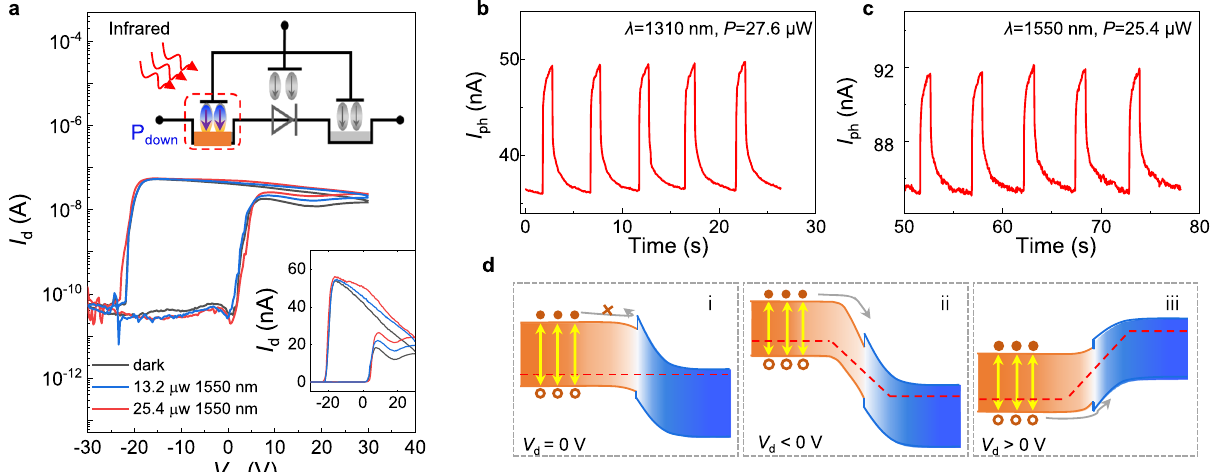
Fig. 4 Photoresponse in near-infrared spectroscopy. a Transfer curves under the illumination of 1550 nm light at V d = 1 V. Time-resolved photocurrent with incident light wavelengths of b 1310 nm (P down state, V d = – 1 V) and c 1550 nm (P down state, V d = 1 V). d Transport of the carriers generated by